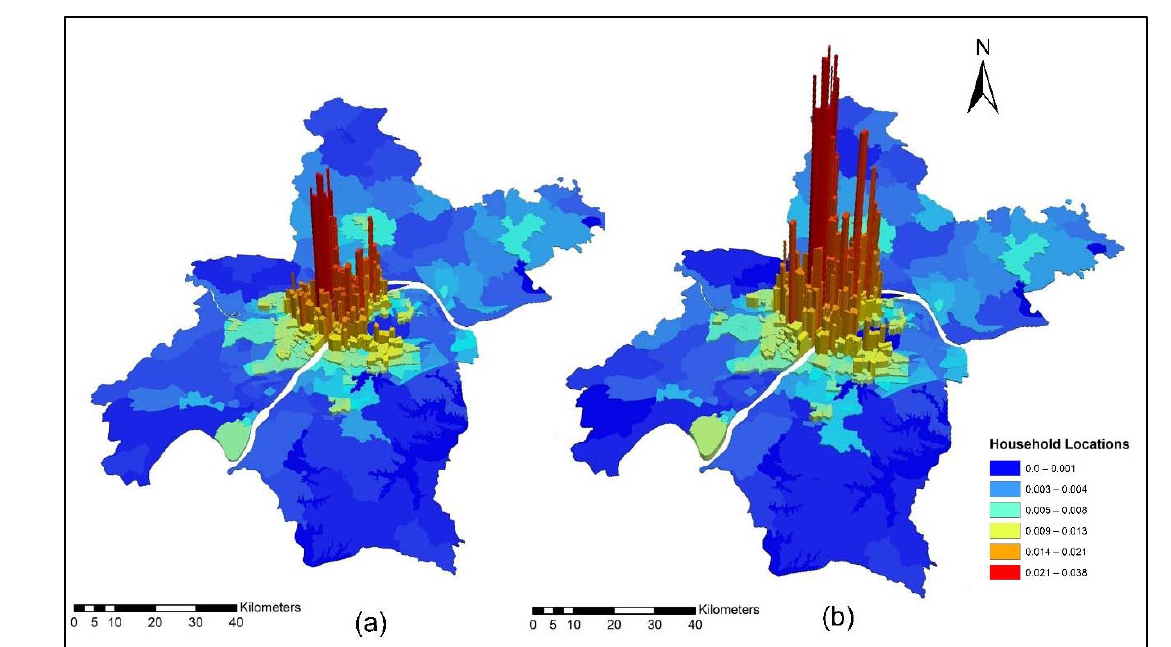
Figure 11. ( a , b ) ISE-estimated household locations: ( a ) during off-peak for the year 2012; ( b ) during off-peak for the year 2015.